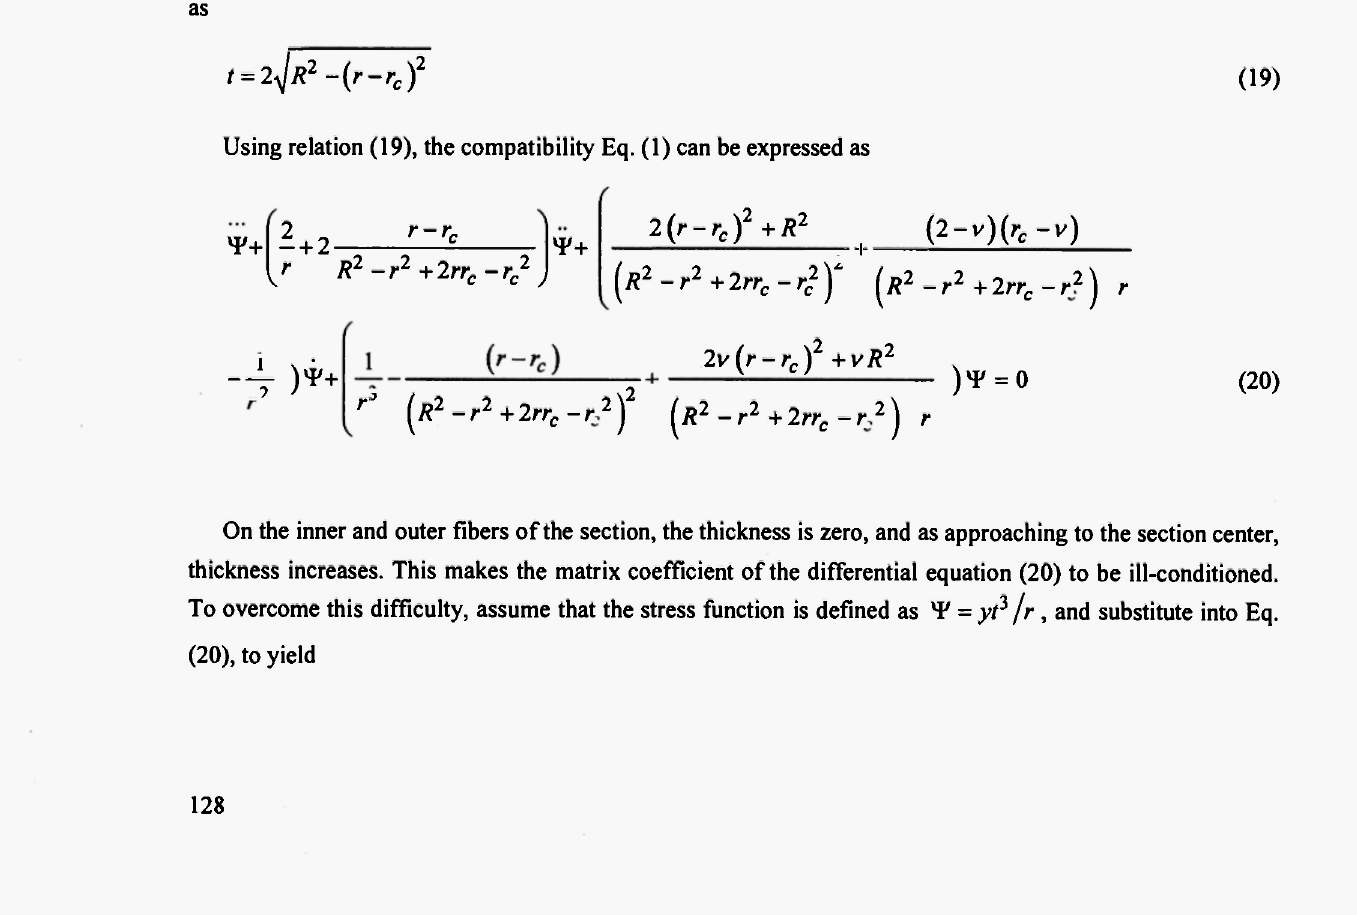
Fig. 3: Parameters of a curved beam with circular